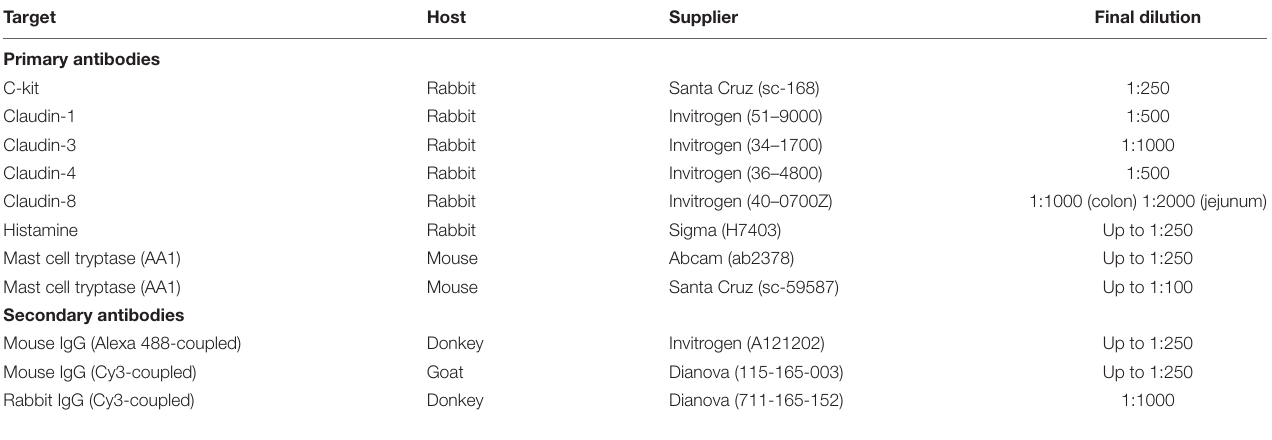
TABLE 1 | Primary and secondary antibodies used for immunofluorescent staining.